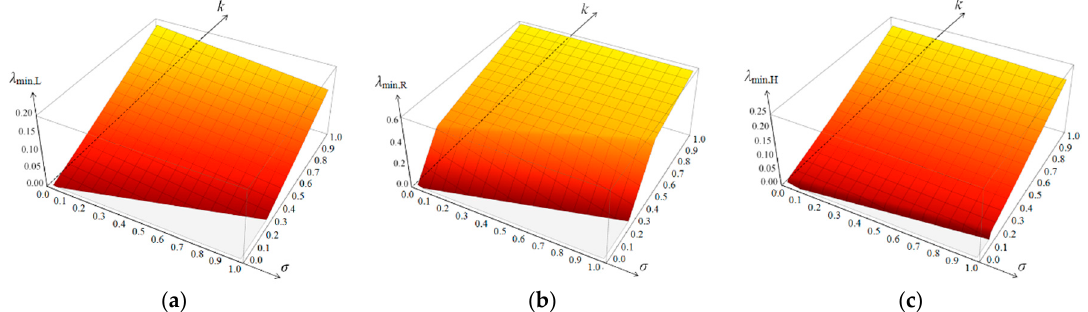
Figure 4. Distributions of lowest eigenvalue for: ( a ) Low; ( b ) Regular; ( c ) High metamaterial.